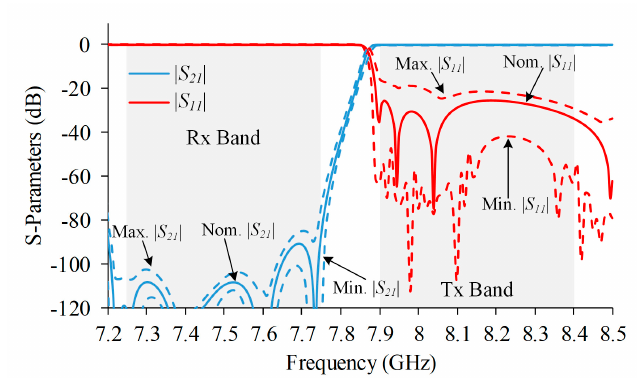
Figure 9. Simulated results of the designed Tx band filter with dimension from Table 2. Magnitude of S 11 is plotted with red color whereas magnitude of S 21 is plotted with blue color. Solid lines correspond to nominal values and dashed lines limit the maximum and minimum values obtained after performing a yield analysis with ±20 μ m standard tolerance. Table 2. Tx band filter dimensions.